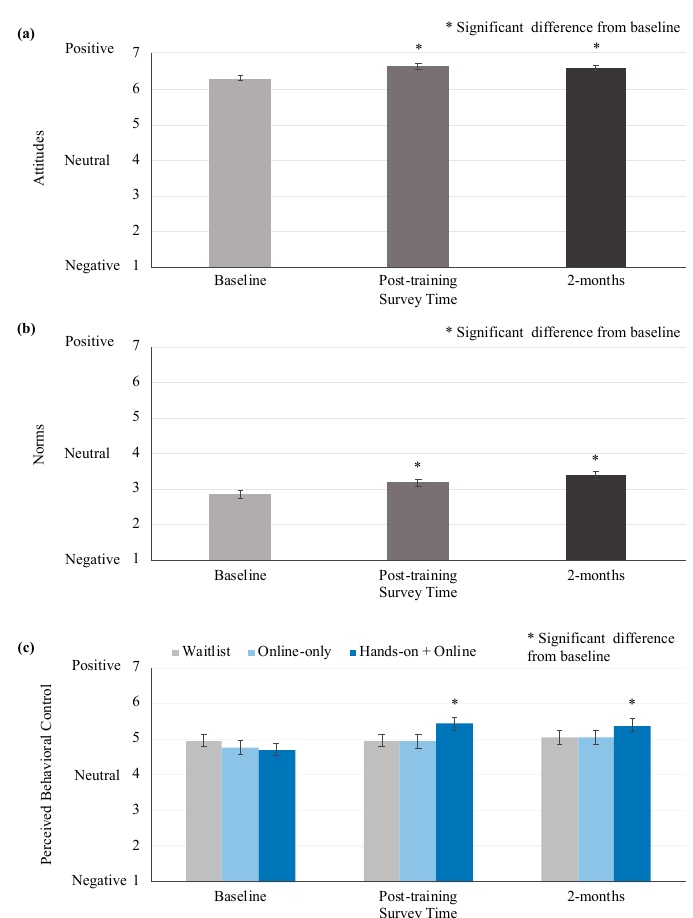
Figure 5. Beliefs about rat tickling. This figure shows the highest order significant associations from general linear mixed models of ( a ) attitudes, ( b ) subjective norms, and ( c ) perceived behavioral control with rat tickling. Variables were measured via a self-report survey. Models were run controlling for potential confounding variables. Scales display only the range of possible responses. Data is presented as least squares mean ± standard error of the mean. (a & b) * Indicates a significant difference from baseline. (c) * Indicates a significant difference from baseline within the treatment group.